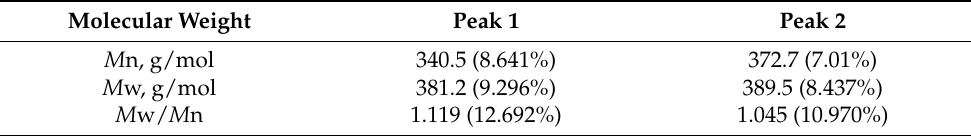
Table 1. The molecular weight and distribution of